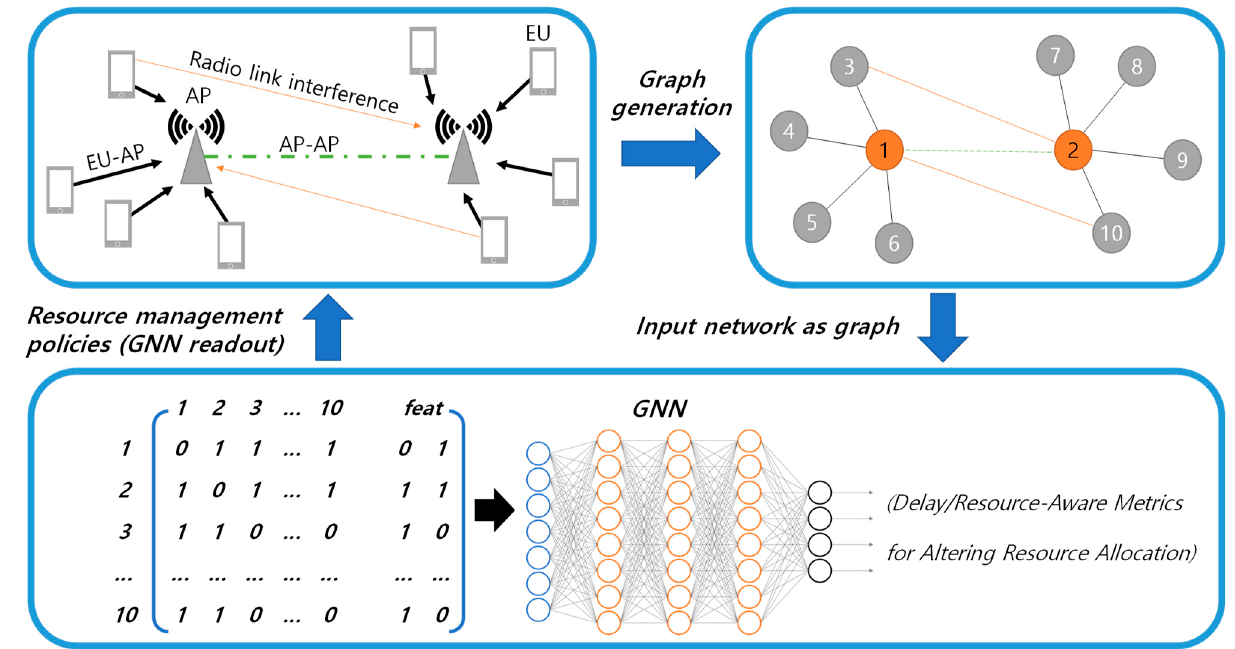
Figure 5. Relations of GNN and network graphs for delay/resource-aware resource management.